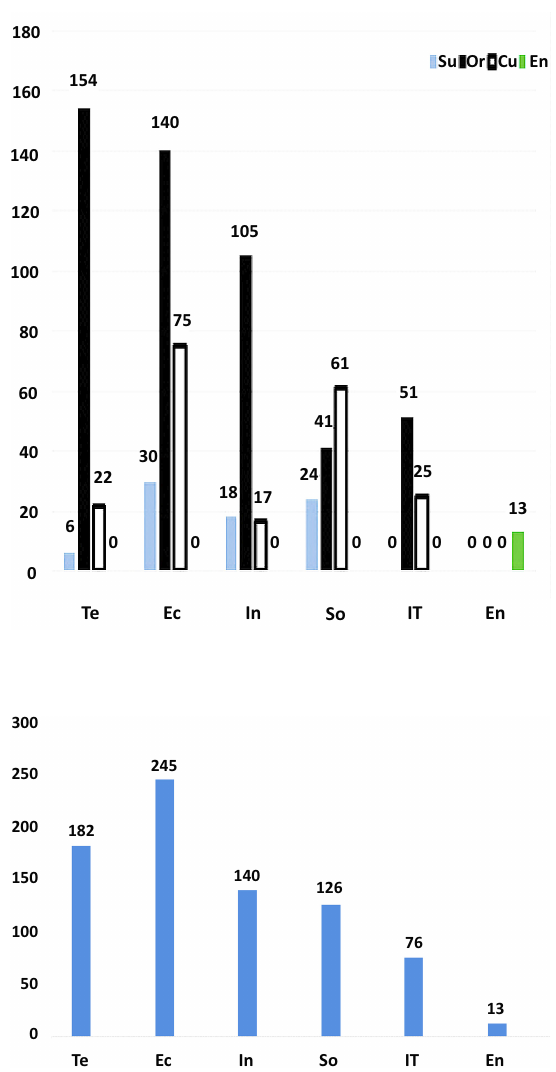
Figure 13. The risk generation scores of each dimension of